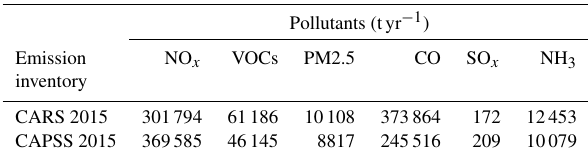
Table 2. The total emissions comparison between CARS and CAPSS for 2015